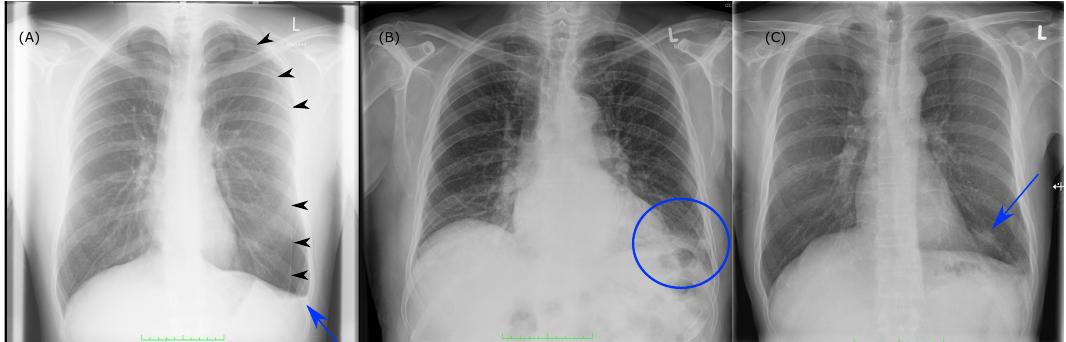
Figure 4. Example cases of the study—( A ) patient with the finding of a seropneumothorax, the pleural dehiscence is marked with black arrowheads (detected by BCR, RR, but missed by 2/3 of NRR, the one NRR reader who found the dehiscence though picked the indifferent option 2 on the 0–4 Likert scale), the pleural effusion is marked with a blue arrow (detected by 2/3 BCR and 3/3 RR, missed by 3/3 NRR); ( B ) patient with a consolidation in the left basal lung. 3/3 BCR and 2/3 RR claimed that pneumonia might be possible (option 2). 0/2 NRR suspected pneumonia. Pleural effusion was suspected by 1/3 BCR, 2/3 RR, 2/3 NRR (options 2 and 3); ( C ) patient with a nodule in the basal left lung (blue arrow) which was detected and classified as potentially suspicious by 3/3 BCR (always option 4), 3/3 RR (options 4/2/2) and only 1/3 NRR (options